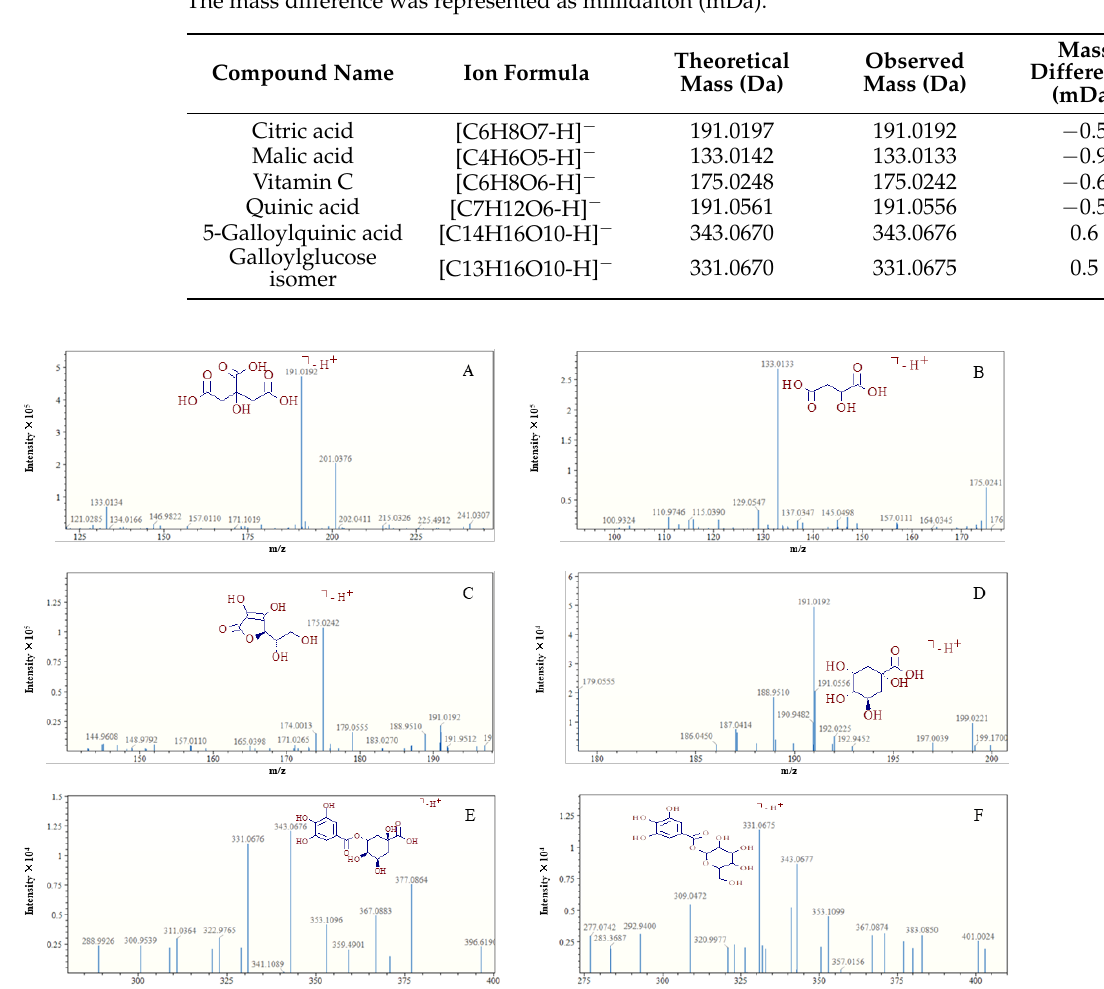
Figure 2. Representative AFAI-MSI spectra: citric acid ( A ), malic acid ( B ), vitamin C ( C ), quinic acid ( D ), 5-galloylquinic acid ( E ), galloylglucose isomer ( F ). Table 1. Ion formula, theoretical mass, and observed mass of low molecular metabolites in mango. The mass difference was represented as millidalton (mDa).